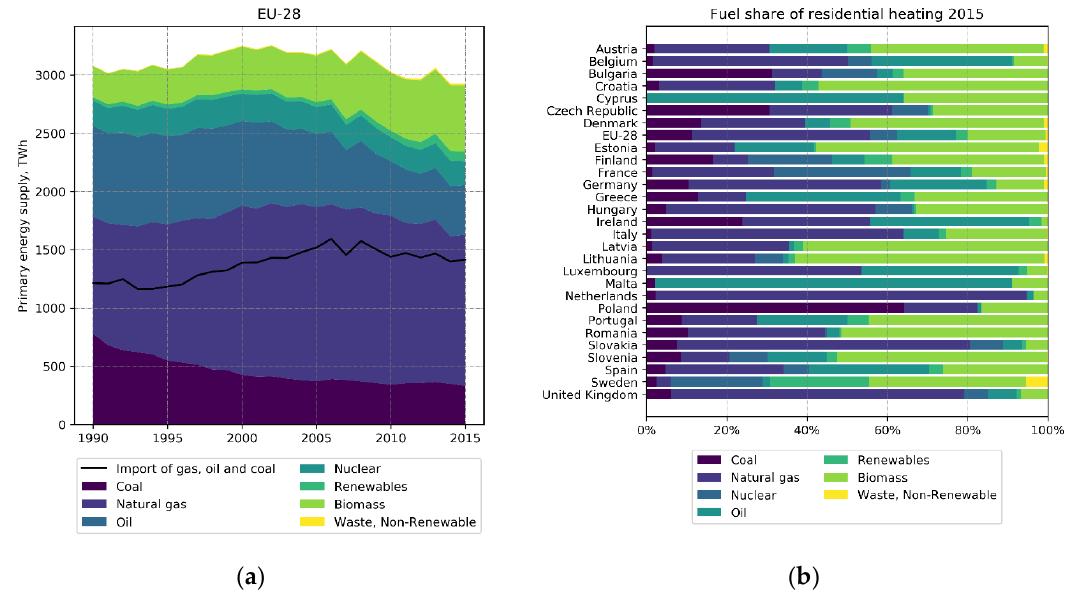
Figure 2. ( a ) Development of primary energy supply for residential heating consumption from 1990 to 2015 in the EU-28 with the respective imports into the EU-28 of gas, oil and coal for residential heating. Results are climate adjusted. ( b ) Primary energy fuel share for residential heating in 2015 of the EU-28 member states.